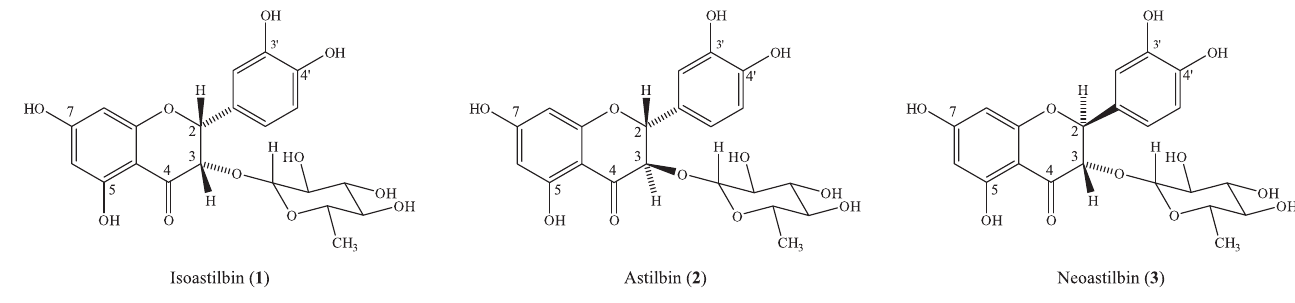
FIGURE 1 - Isolated flavonoids of the extract of Heteropteris aphrodisiaca . ( 1 ) isoastilbin, ( 2 ) astilbin and ( 3 )